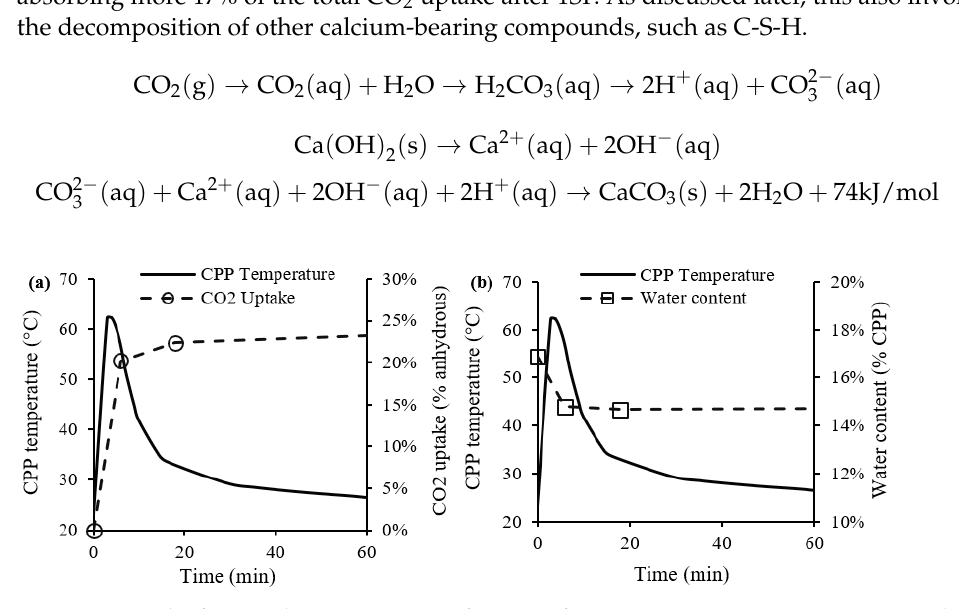
Figure 3. Results from carbonation process for 80% of CO 2 concentration: temperature and CO 2 uptake ( a ); temperature and water content ( b ).